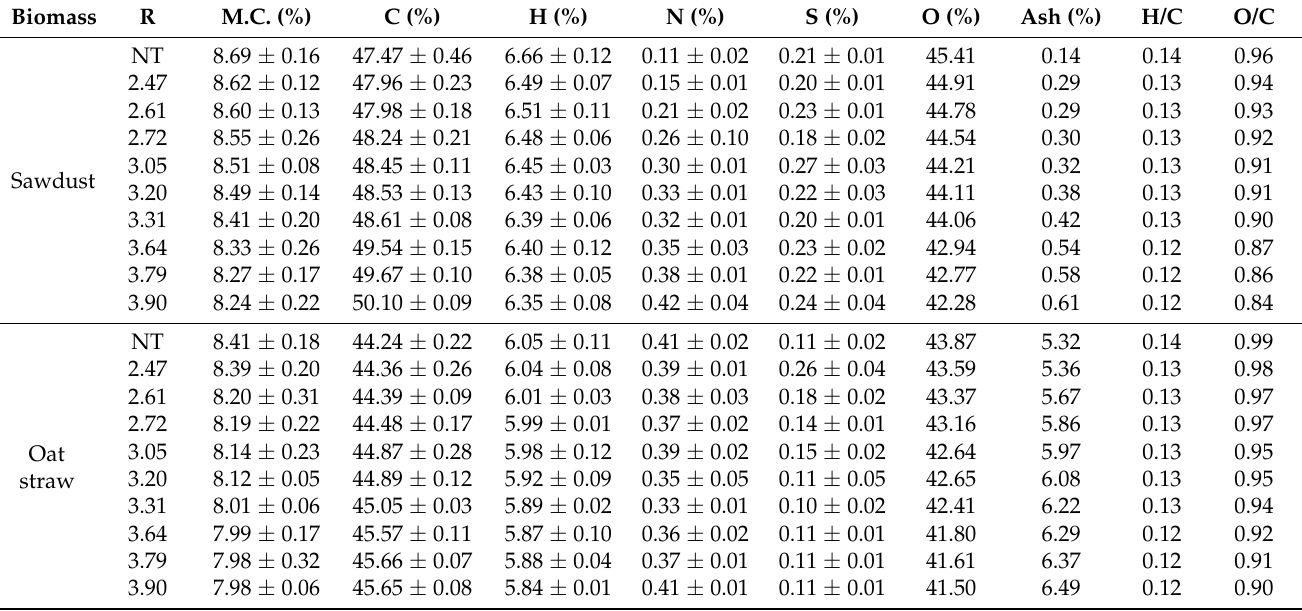
Table 2. Elemental composition and final moisture content of steam-exploded and non-treated biomass grinds (dry matter